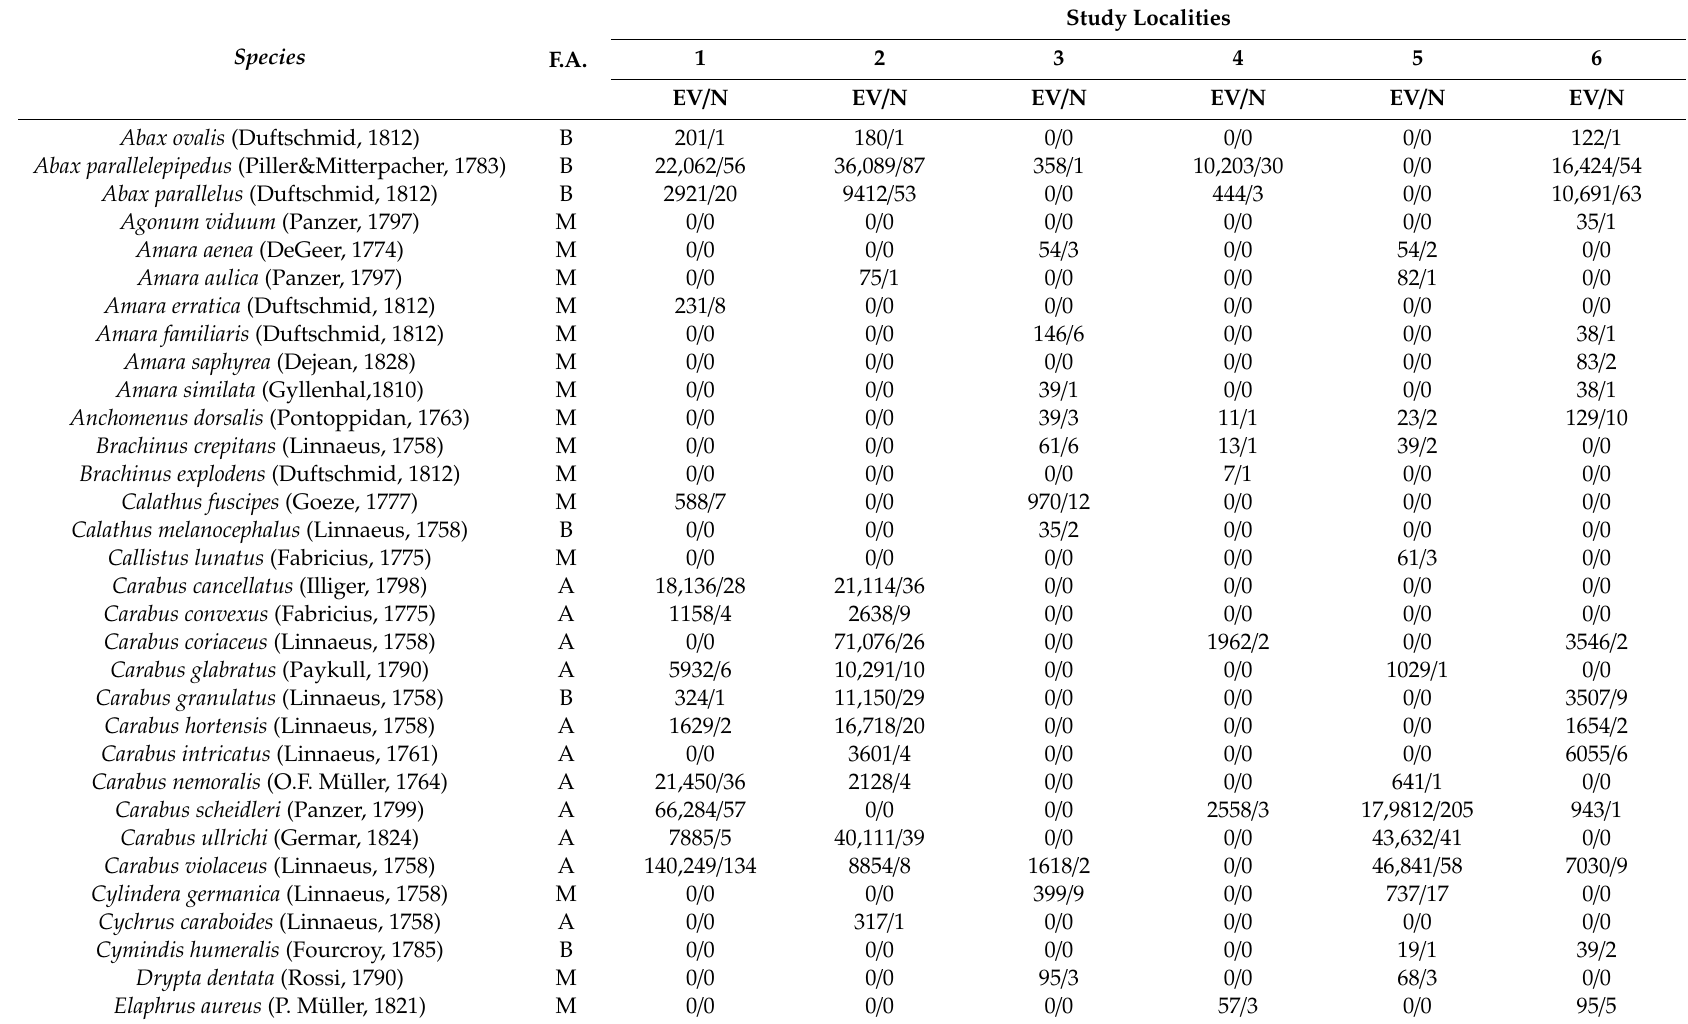
Table 2. List of species of study sites and ellipsoid biovolume (EV) values (mm 3 ). Study Localities Species F.A. 1 2